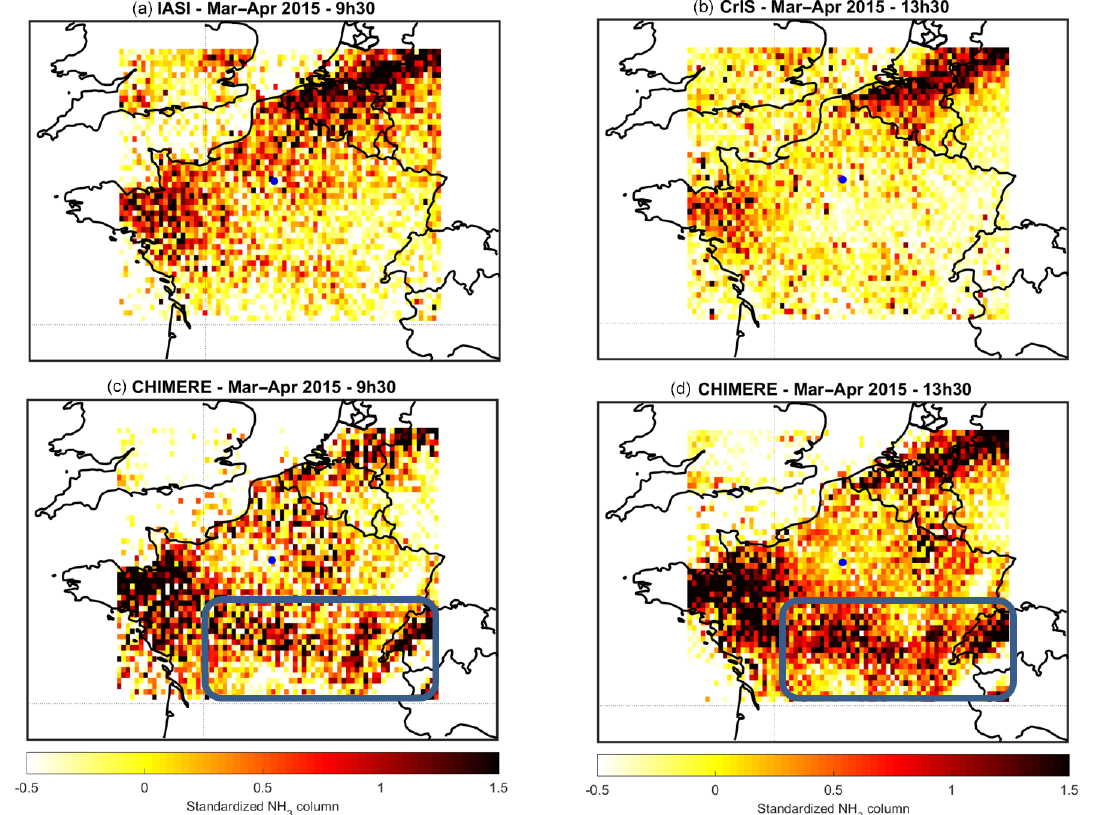
Figure 9. Same as Fig. 8 but for March–April 2015.